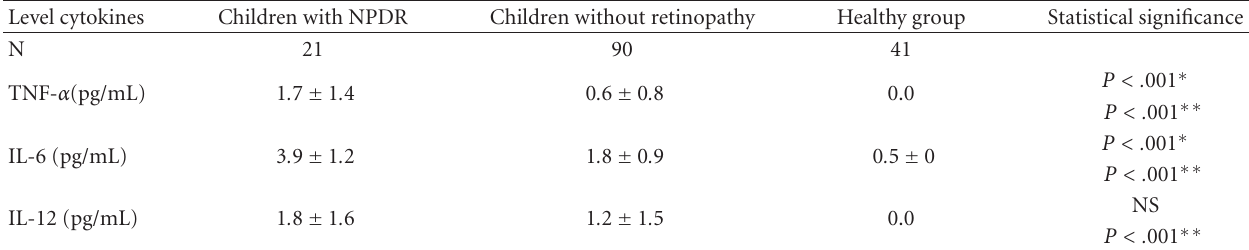
∗ Di ff erences between children with nonproliferative retinopathy and without retinopathy. ∗∗ Di ff erences between children with nonproliferative retinopathy and healthy